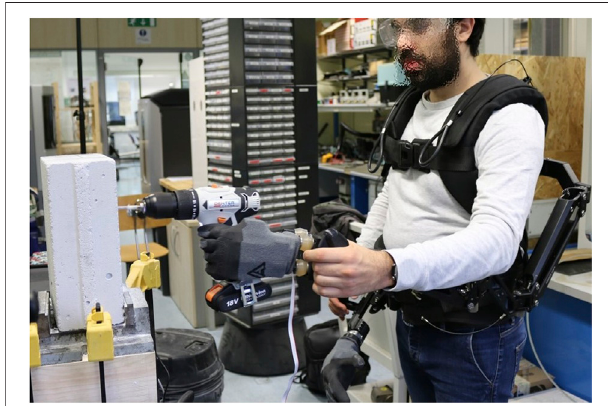
FIGURE1| AsubjectdrillsablockofSIPOREXusingthesupernumerary system, which is composed of the Armor Man ® , the Pisa/IIT SoftHand, and a customized damping wrist. The tool is held by the system, which contributes to a simultaneous load relocation and vibration transmission reduction.